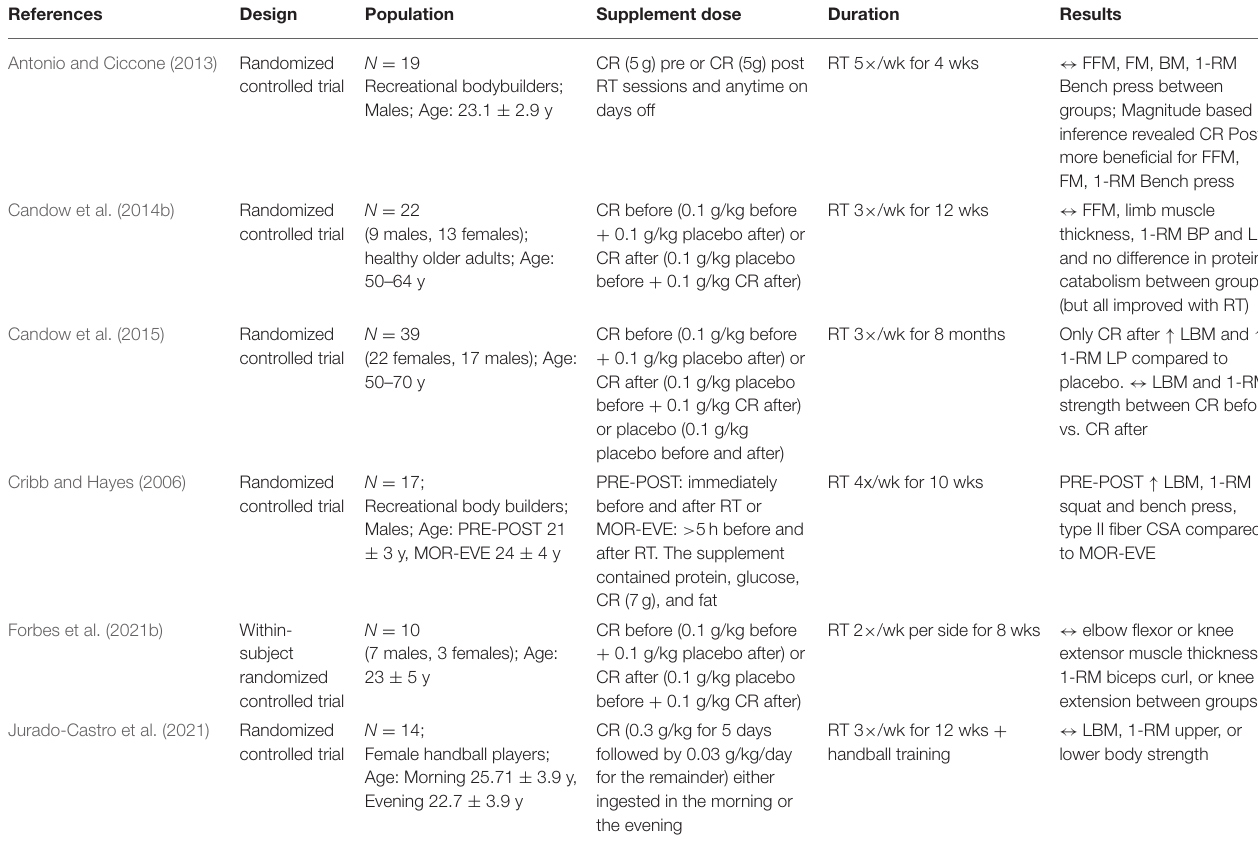
TABLE 1 | Summary of studies investigating strategic timing of creatine ingestion. Design Population Supplement dose